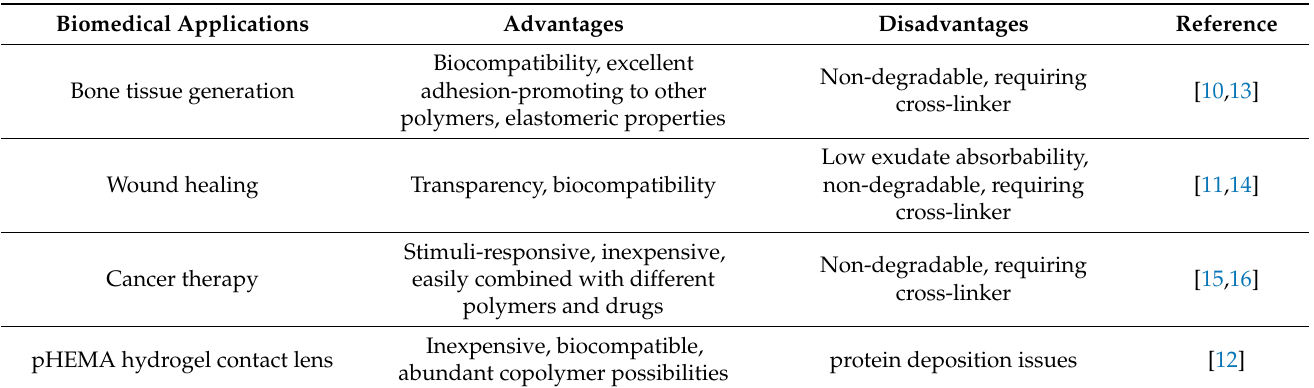
Table 1. Briefly summarizes the biomedical applications of pHEMA, advantages, and disadvantages. Biomedical